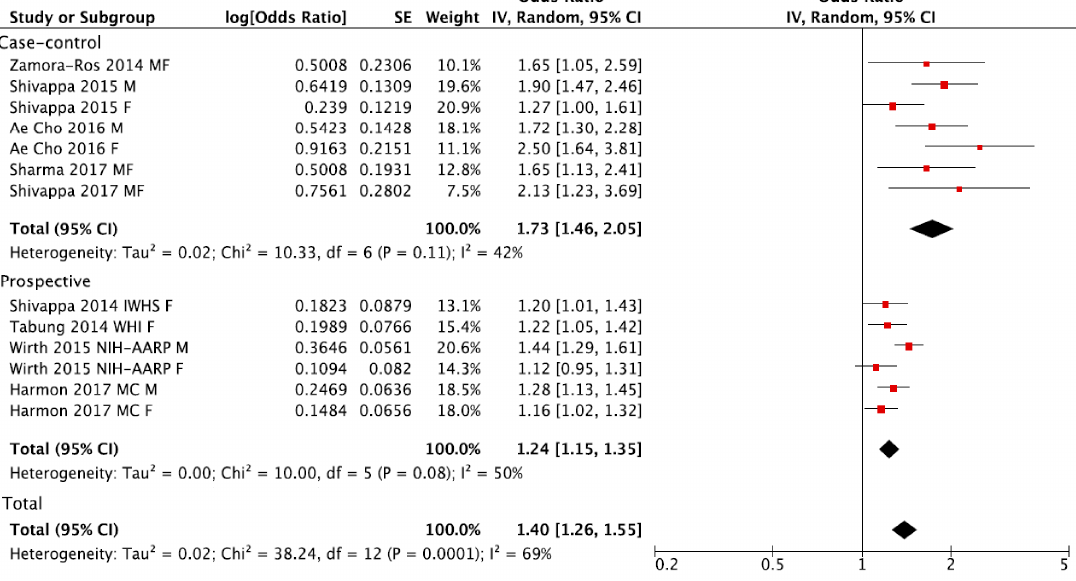
Figure 2. Forest plot of summary relative risks (RRs) of colorectal cancer for the highest versus lowest (reference) category of Dietary Inflammatory Index (DII), for case-control, prospective and all studies.